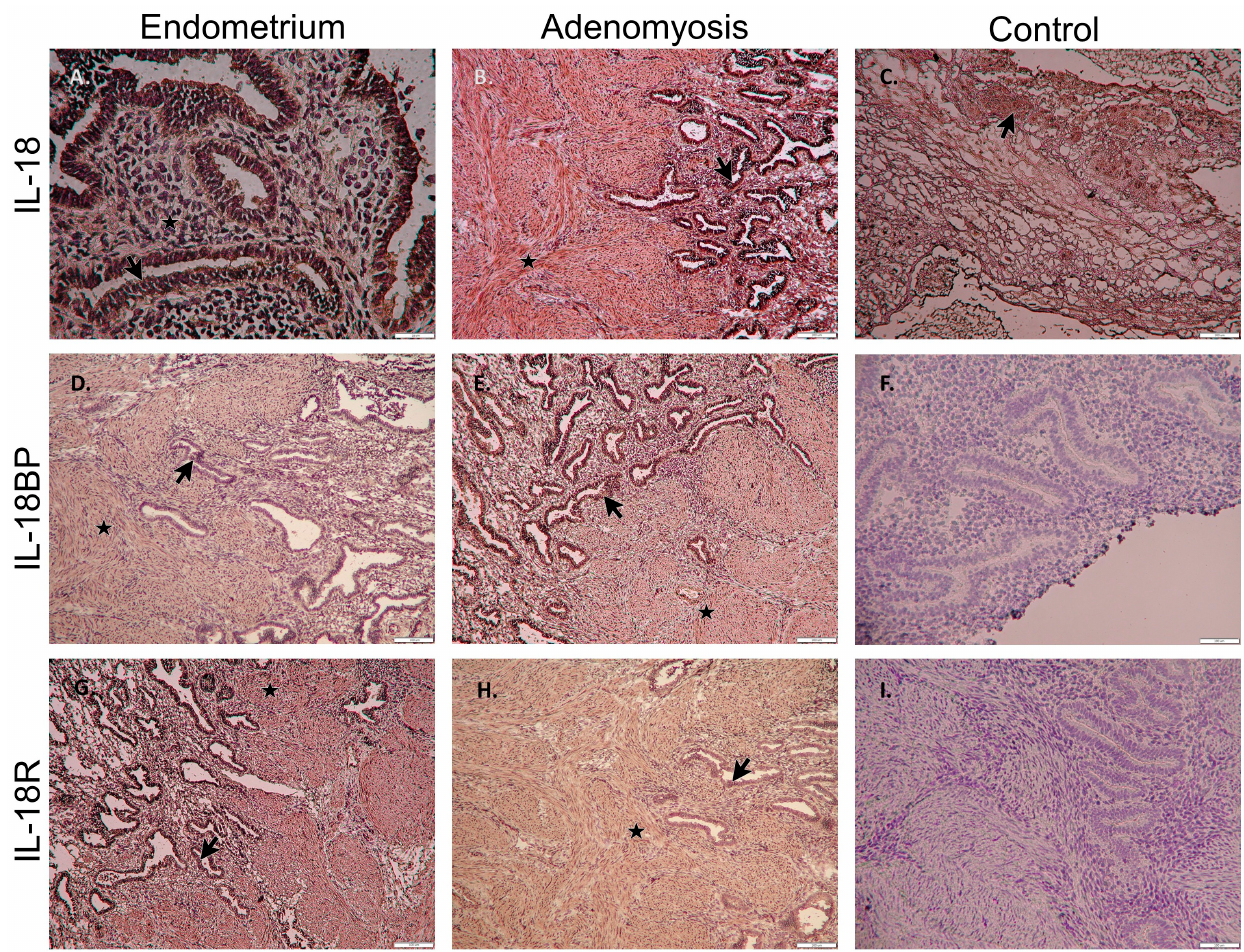
Figure 2. Immunohistochemistry of IL-18 system in patients with adenomyosis. A brown stain indicated a diffuse IL-18 system positive reaction in luminal epithelium (arrow) and stromal cells (star) of eutopic ( A , D , G ) and ectopic ( B , E , H ) endometrium. The human placenta was a positive control of IL-18 ( C ). Negative control was also presented by omitting the primary antibodies of IL-18BP ( F ) and IL-18R ( I ). ( A ) scale bar = 20 μ m; ( B – I ) scale bar = 100 μ m.